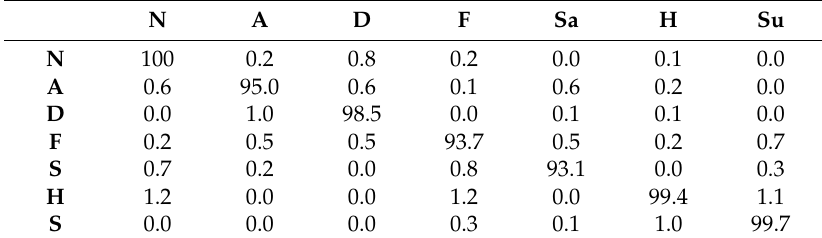
Table 5. The results obtained by the CK+ database.